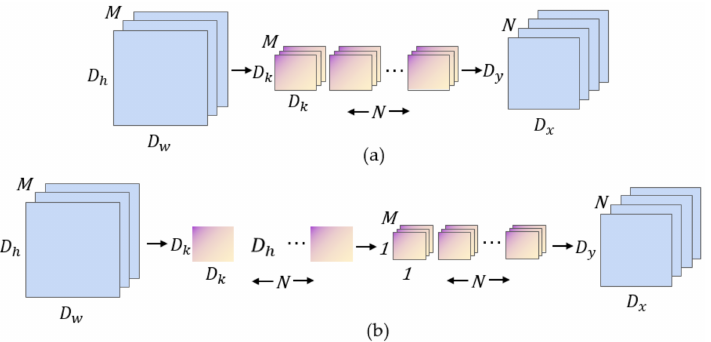
Figure 5. Standard convolution and depthwise separable convolution. ( a ) Standard convolution; ( b ) Depthwise separable